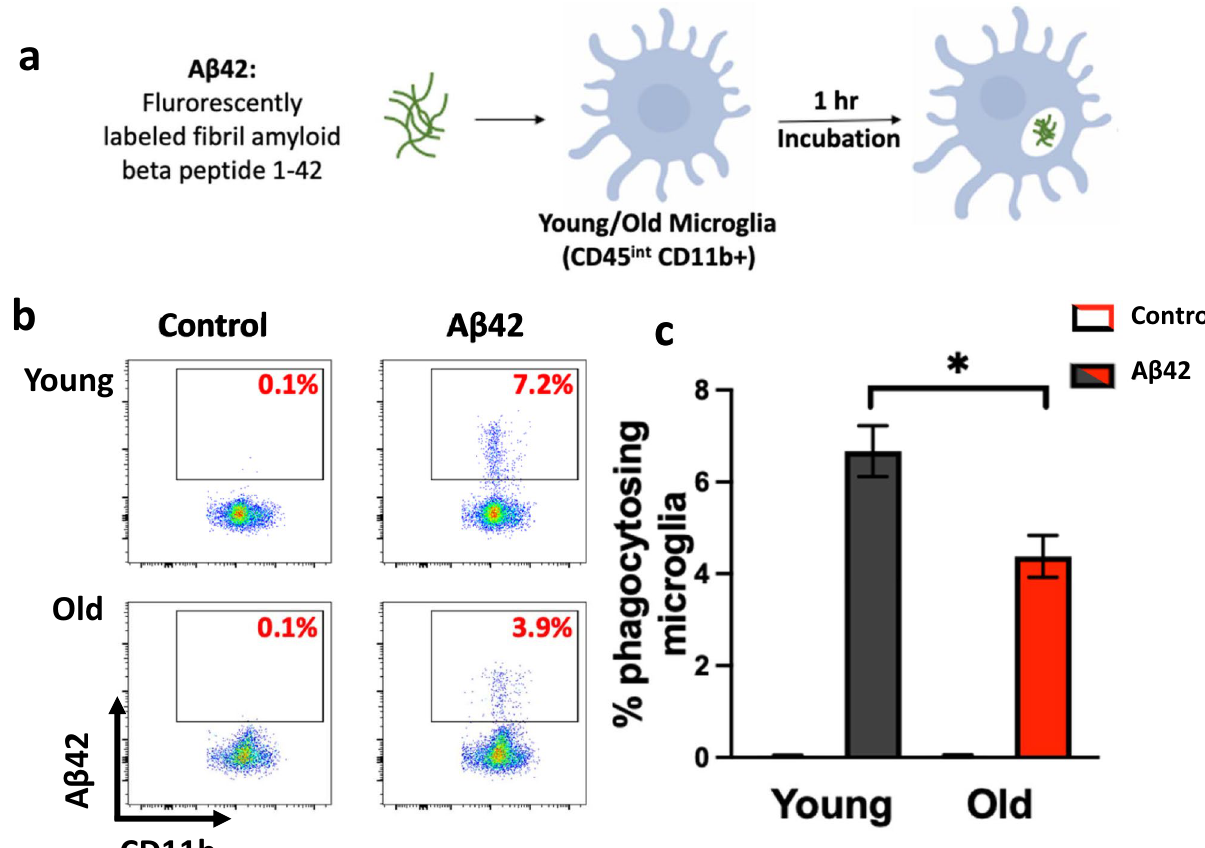
Figure 1. Aged microglia have reduced phagocytic capacity. Brains from female young (2 months) and old (19 months) mice (n = 3) were processed and live CD45 intermediate CD11b + cells (microglia) were assessed for phagocytic capacity. ( a ) Cells were incubated with 0.5 μM of fluorescent fibril Aβ42 or medium (control) for 1 h and phagocytosis was assessed by flow cytometry, images made using ©BioRender - biorender.com. ( b – c ) Representative flow plots of 1 replicate of 4 are shown and mean ± s.e.m % of microglia showing phagocytosis of fluorescent Aβ42 are graphed * p ≤ 0.05, Student’s t